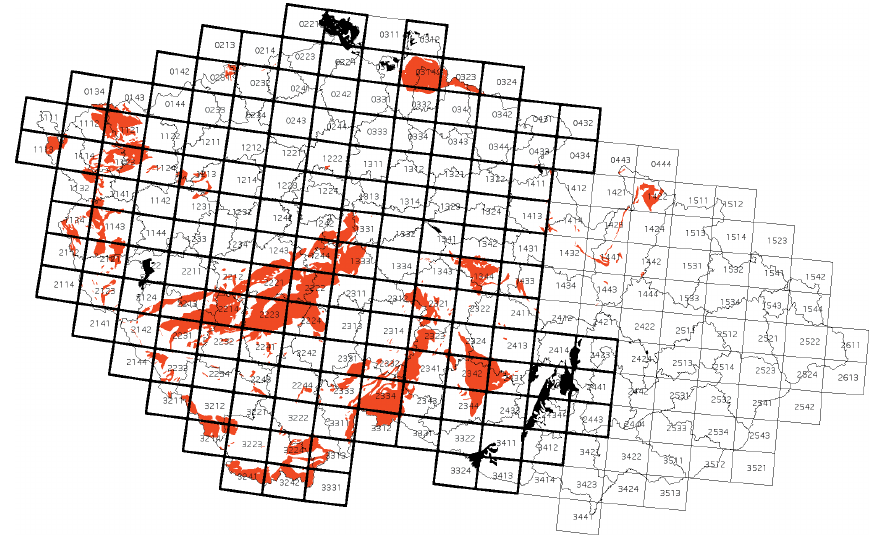
Fig. 4. Czech Republic – completed radon risk map sheets 1:50 000 (bold framed). The priority of map sheets pro- cessing was oriented to cover dominantly the extent of granitoid bodies within the Czech